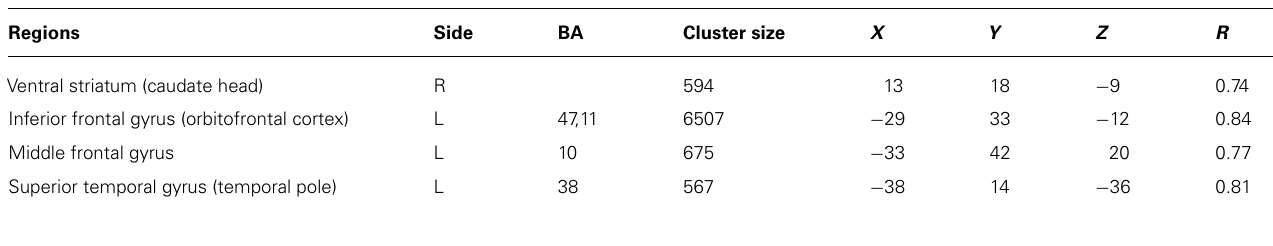
Table 4 | Regions with significant positive correlation ( p < 0.001, cluster size threshold of 16 voxels) between individual values within the SWAP-200 factor “Emotional-Hostile-Externalizing” and beta values for the contrast OPD > traffic.